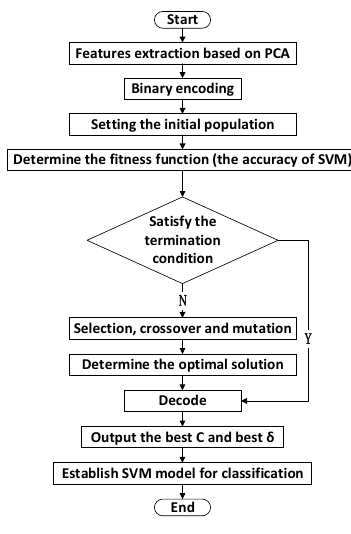
Figure 5. GA-SVM modeling flow chart.